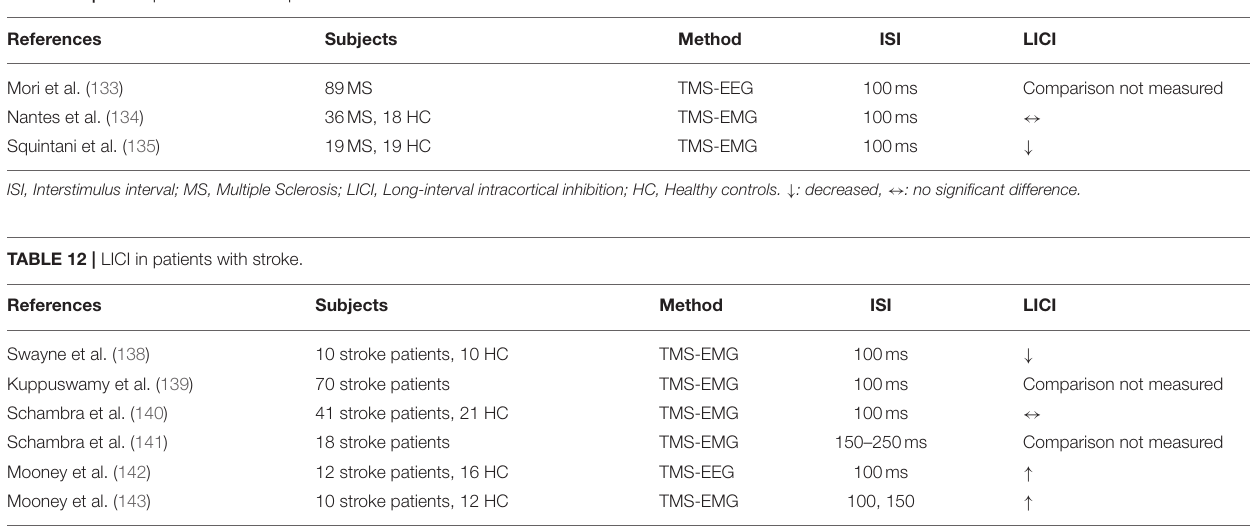
TABLE 11 | LICI in patients with multiple sclerosis.